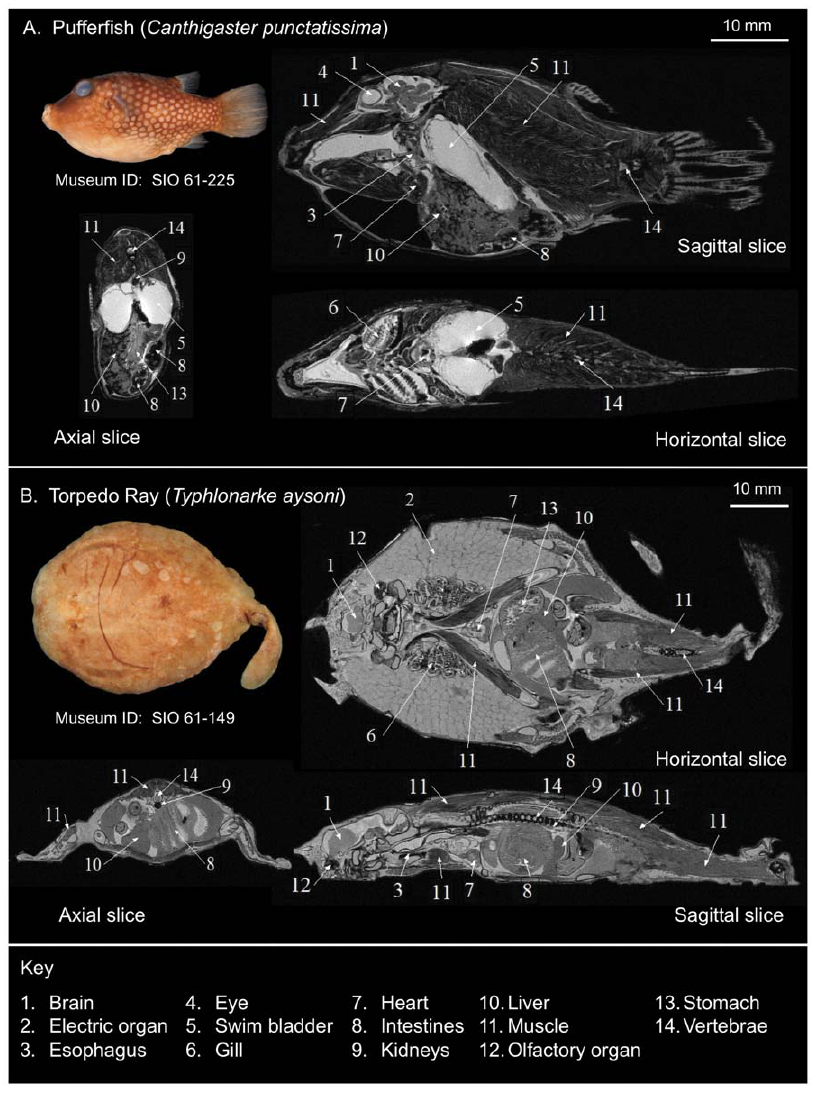
Figure 3. Examples of T1-weighted contrast-enhanced 7T MRI data. (A) Spotted sharpnose puffer, Canthigaster punctatissima (SIO 61-225, SL 57 mm). Pulse sequence parameters include: FA=15 u , TR=22.814 ms, TE=11.322 ms, slice thickness=100 m m, slice matrix=354 6 780 6 210, resolution=100 m m 3 , averages=5. (B) Blind legged torpedo, Typhlonarke aysoni (SIO 61-149, SL 92 mm). Pulse sequence parameters include: FA=15 u , TR=23 ms, TE=11.222 ms, slice thickness=100 m m, slice matrix=550 6 830 6 180, resolution=100 m m 3 , averages=3. Numbered labels indicate a selection of readily visible anatomical structures in these slices.